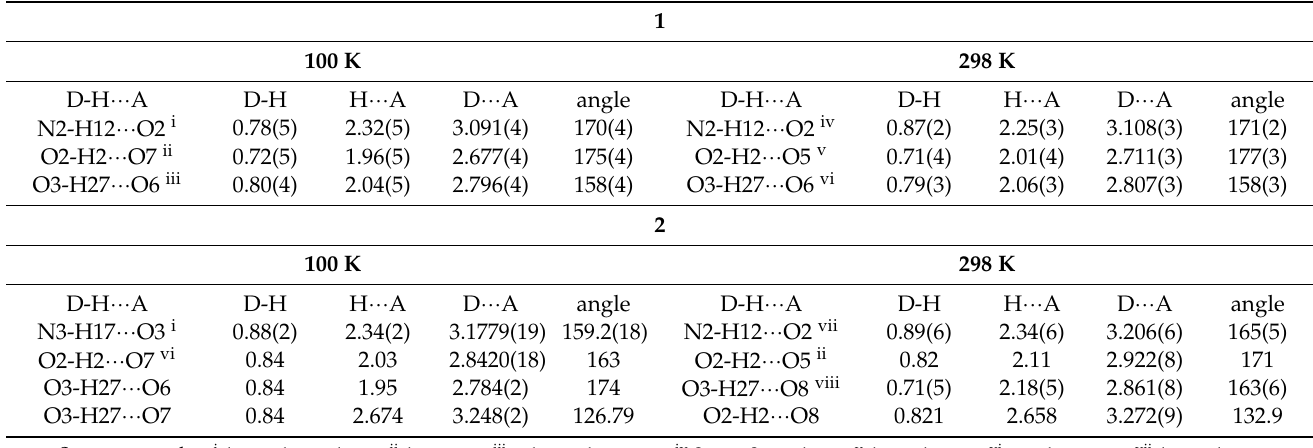
Table 3. Hydrogen bond distances and parameters for the complexes of 1 and 2 (Å, ◦ ).